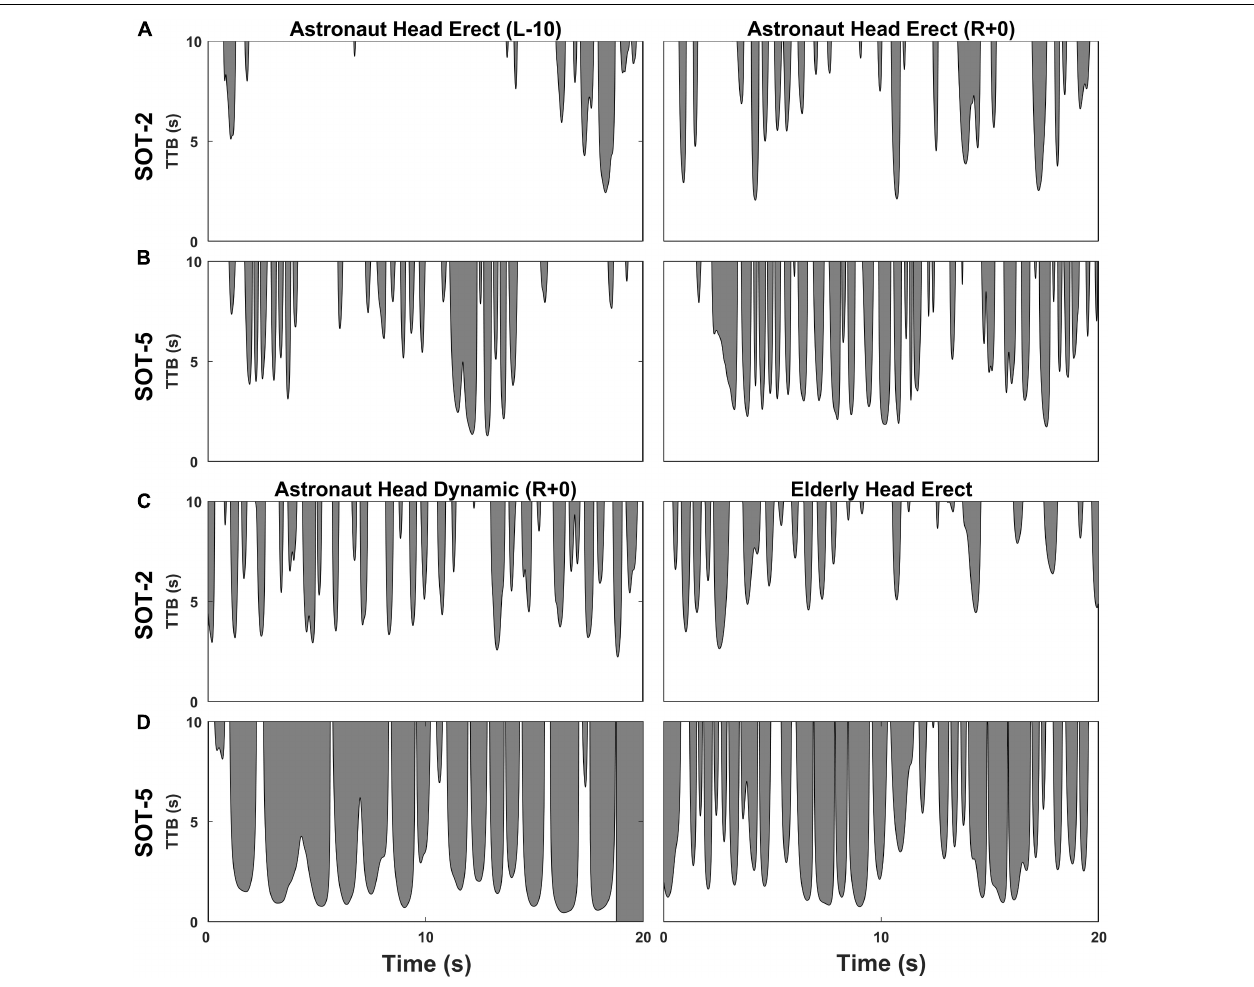
FIGURE 2 | Representative time to boundary (TTB) time series for an astronaut and an elderly subject. Effects of spaceflight on postural control performance can be observed from head erect (HE) trials obtained from a representative astronaut subject before spaceflight (L-10) and immediately after landing (R+0) for both SOT-2 (A) and SOT-5 (B) conditions. Similarities in postural control performance between spaceflight and aging can be observed from head dynamic (HD) trials obtained on return day (R+0) in a representative astronaut subject and head erect (HE) trials obtained in a representative elderly subject for both SOT-2 (C) and SOT-5 (D) conditions. Black lines with shaded regions depict the TTB trace in anterior-posterior direction over each trial truncated at 10 s. Shaded areas indicate the iTTB (absolute) for each trial. The iTTB (%) is computed by dividing the iTTB (absolute) by the total area shown in the plot. The shaded region in (D) for an astronaut subject also show the time instance when TTB value hit zero, indicating a